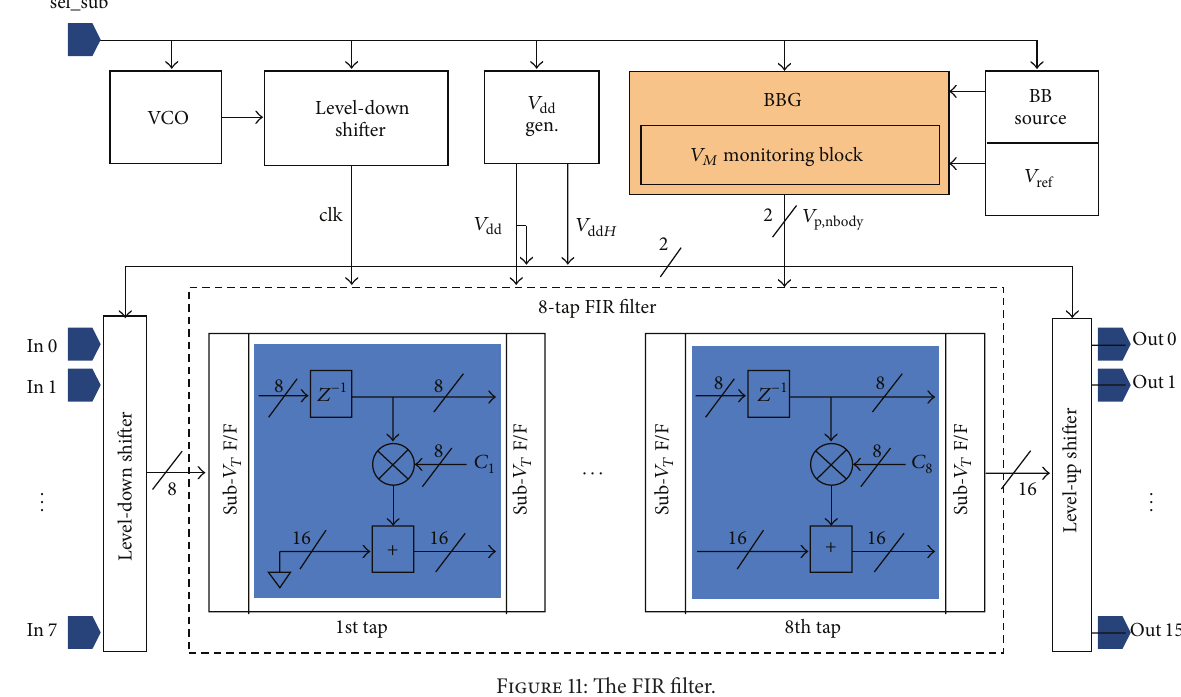
Figure 11: The FIR